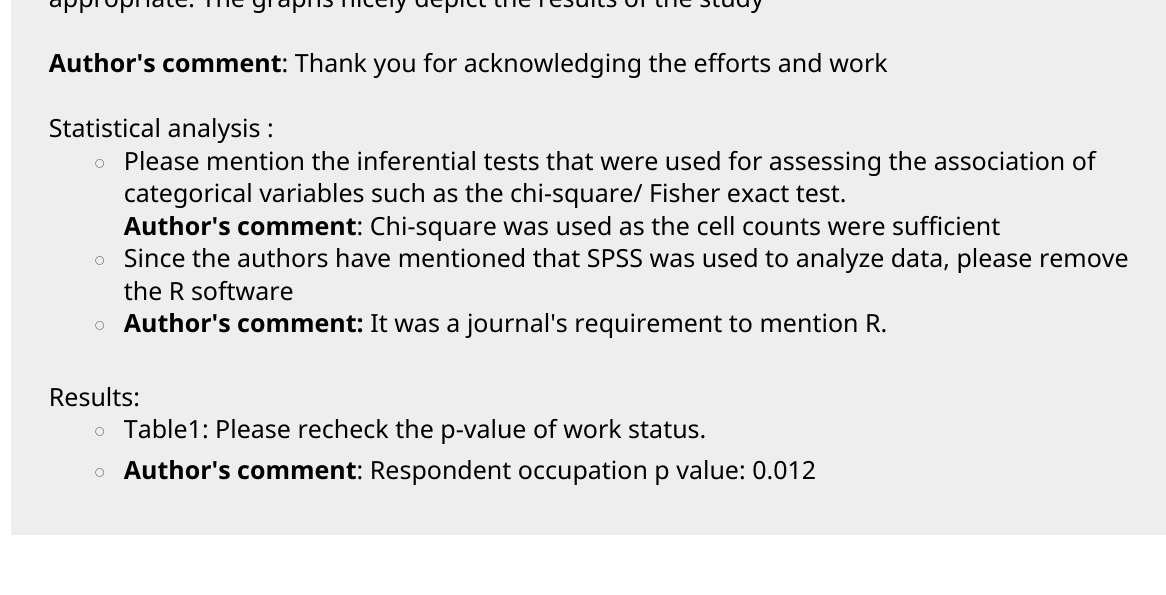
Table1: Please recheck the p-value of work status.